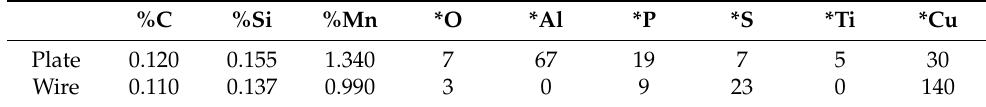
Table 1. Steel plate and weld wire compositions.